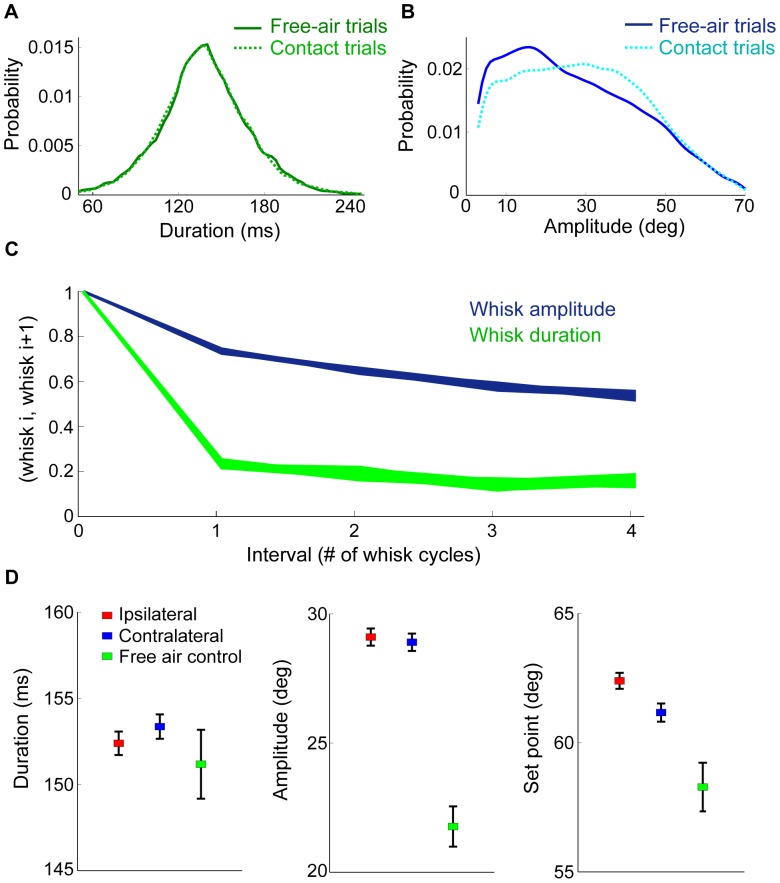
Whisking kinematics in free-air and after contact.
A. Distribution of whisk duration in free-air (dark green) and in contact (light green) trials. B. Distribution of whisk amplitudes in free-air (dark blue) and contact (light blue) trials. The distributions in A and B where smoothed using the MATLAB function fitdist (‘kernel’, width = 2). C. Correlations between the amplitude and duration of pairs of whisks, as a function of the interval between them. D. Whisk duration, amplitude, and set point, before the first “pseudo touch” (free-air trials; green) and the first (real) touch (contact trials; red for the ipsilateral and blue for contralateral sides).